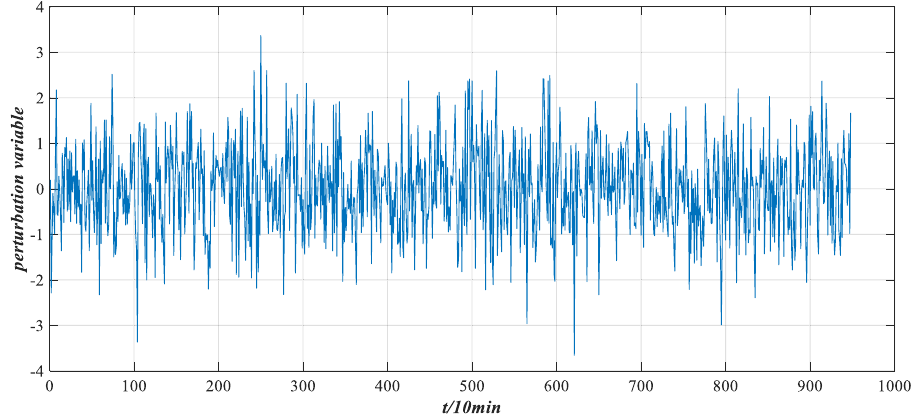
Figure 11. Perturbation variable distribution.